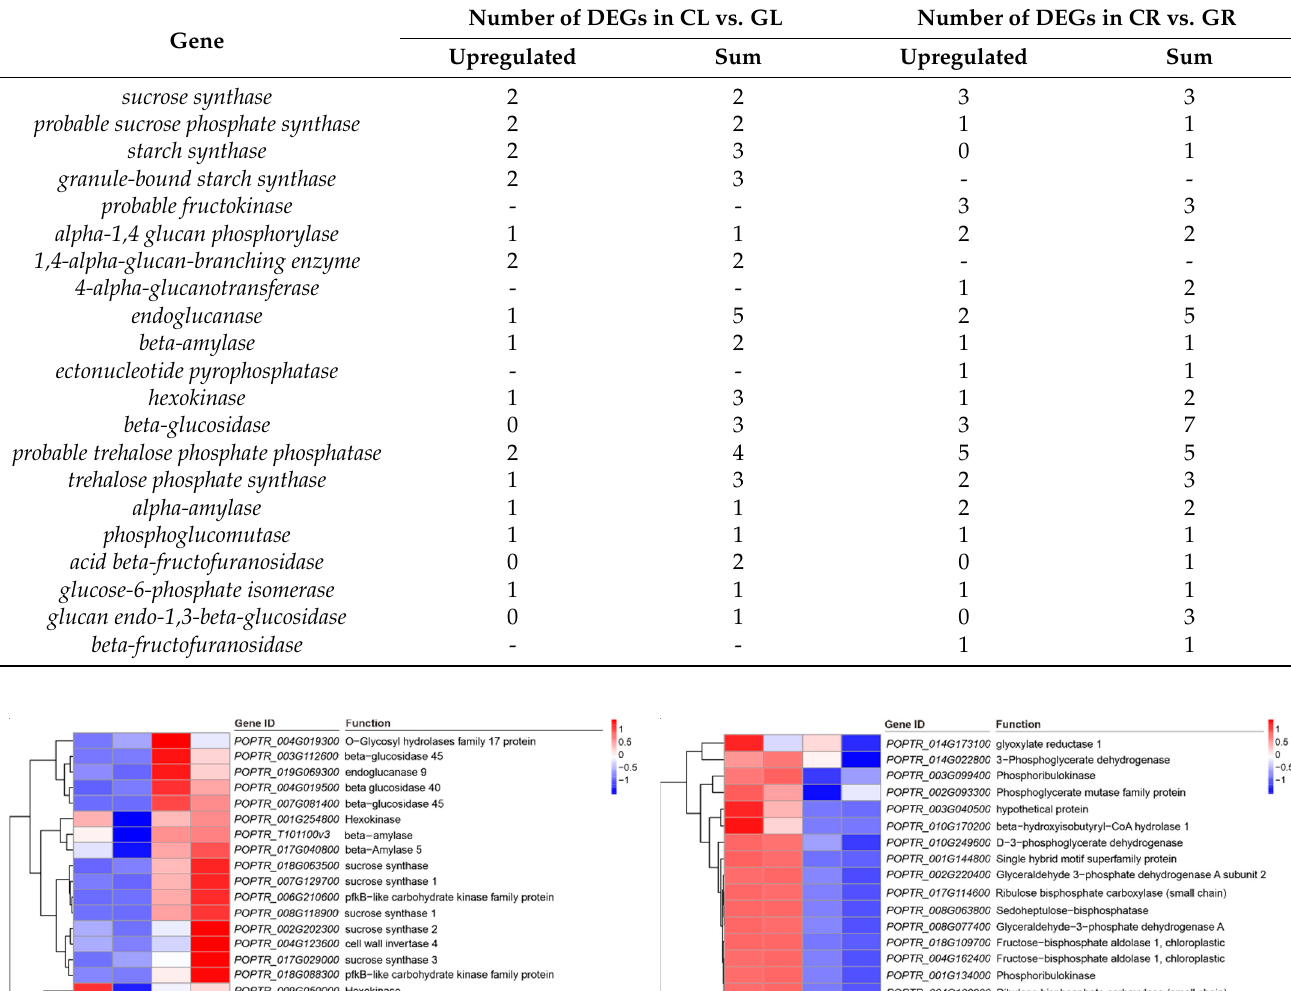
Table 2. DEGs related to starch and sucrose metabolism in the GL and GR libraries.